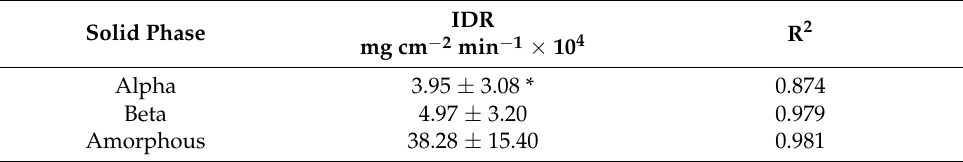
Figure 2. Amount of rifaximin dissolved at 37 °C per unit area from an amorphous phase (triangle) and two crystalline phases ( α form, circle, and β form, square) represented as a function of time. The solid lines represent the linear regression of the experimental points. The bars represent the standard deviation (n = 3). Table 1. Intrinsic Dissolution Rate (IDR) and coefficient of the linear regression of the experimental points (R 2 ) of 2 crystalline forms and one amorphous form of rifaximin. Mean value ± standard deviation (n = 3).